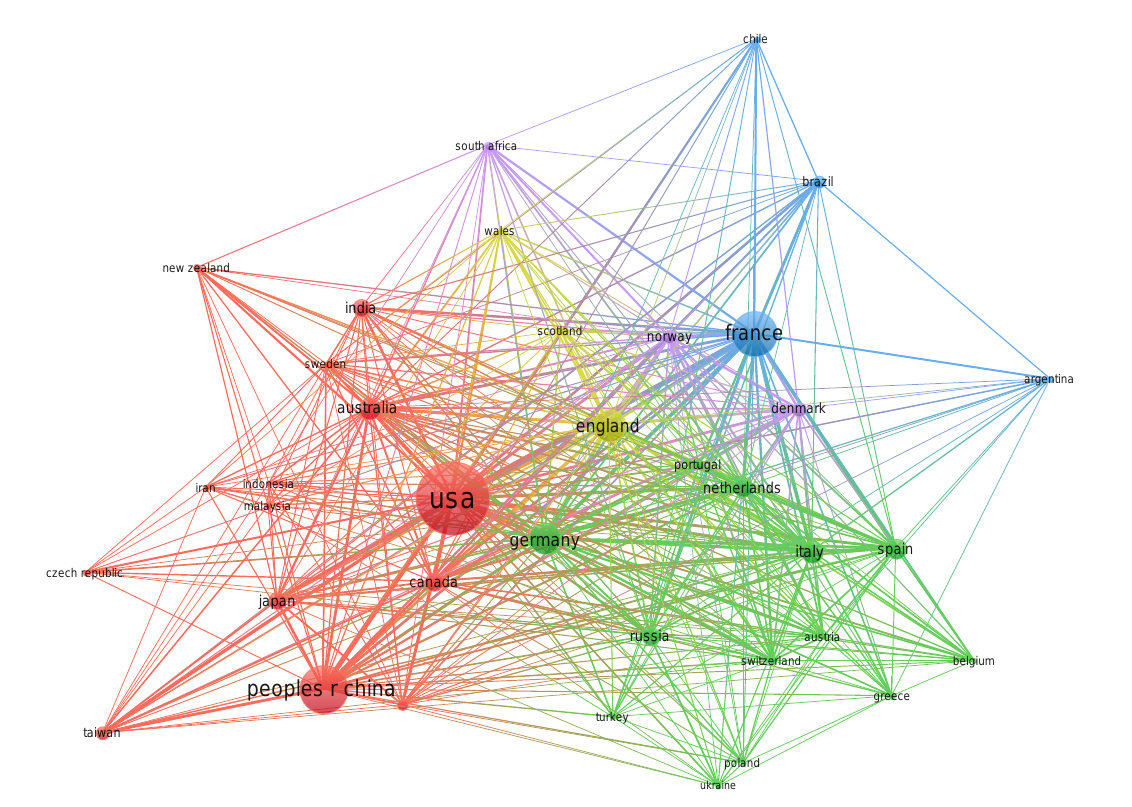
Figure 6. Node diagram of country/region cooperation. The node size indicates the volume of publications for each country. The link line width indicates the strength of the cooperation. Table 2. Top 10 institutions based on total publications. WoS provided the statistical